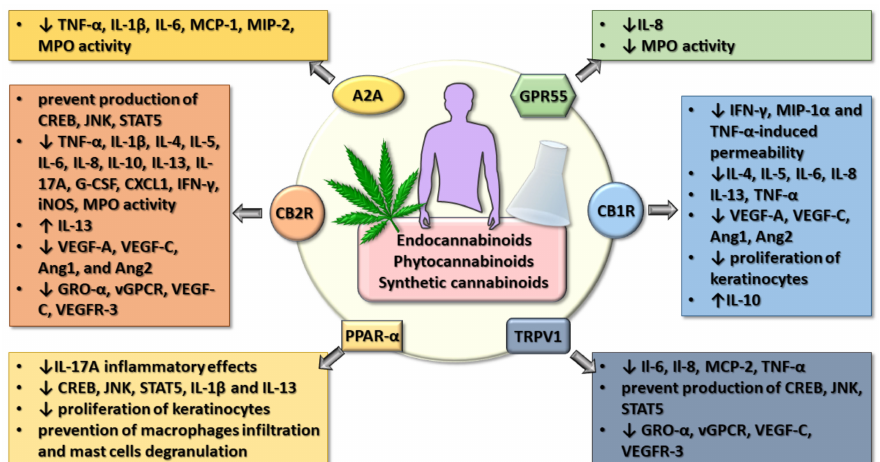
Figure 1. The summarization of the main effects of endocannabinoids, as well as natural and synthetic cannabinoids on several receptors promoting the decrease of inflammation in the gut- lung-skin barrier. ( ↓ ) = decrease in expression and/or concentration; ( ↑ ) = increase in expression and/or